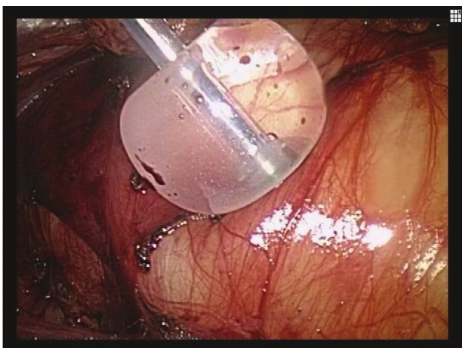
Figure 3: Laparoscopic view showed a wall of the retroperitoneal lymphangioma. Only the inflated proximal balloon is visible.